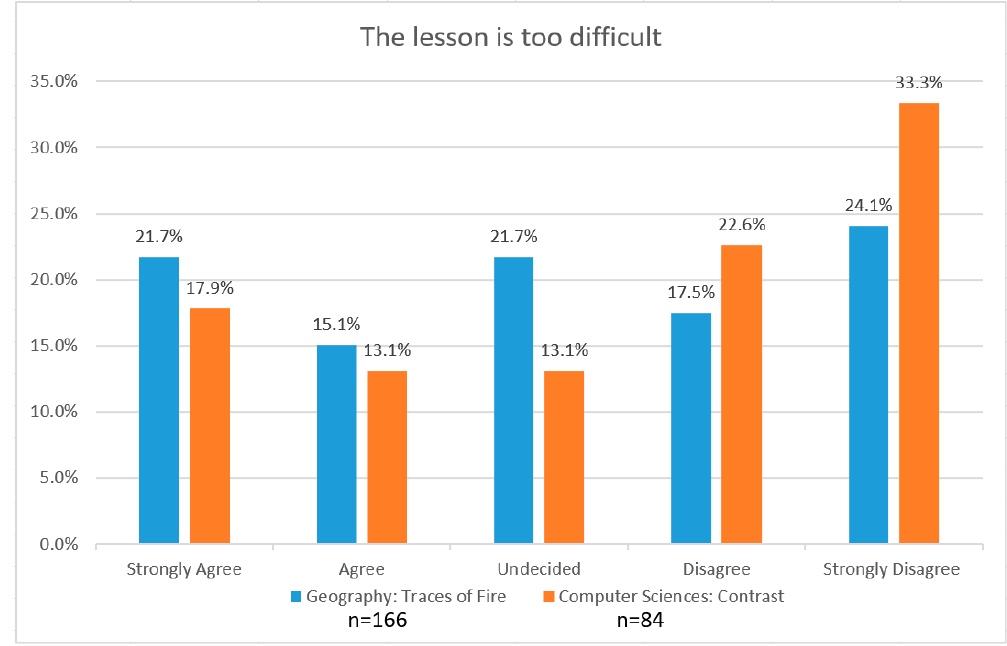
Figure 5. Pupils agreement with the statement: “The FIS learning materials are too difficult”.